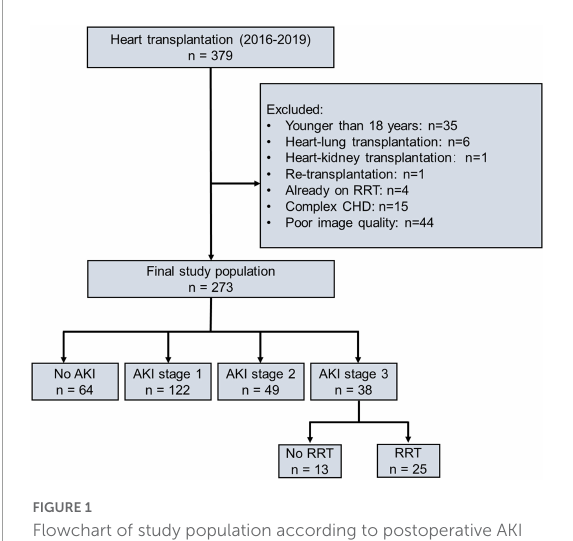
FIGURE1 Flowchart of study population according to postoperative AKI severity. AKI, acute kidney injury; RRT, renal replacement therapy; CHD, complex congenital heart